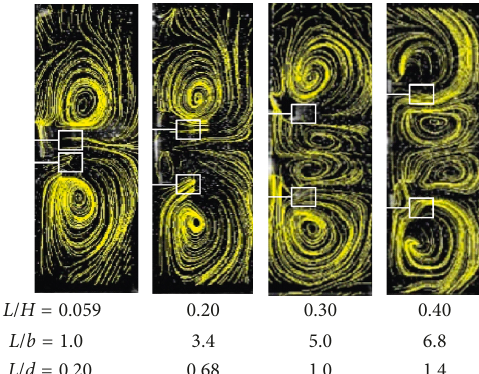
Figure 2: Streamlines with different impeller spacings at Re � 8 ( d / D � 0.43, b / d � 0.20, H / D �